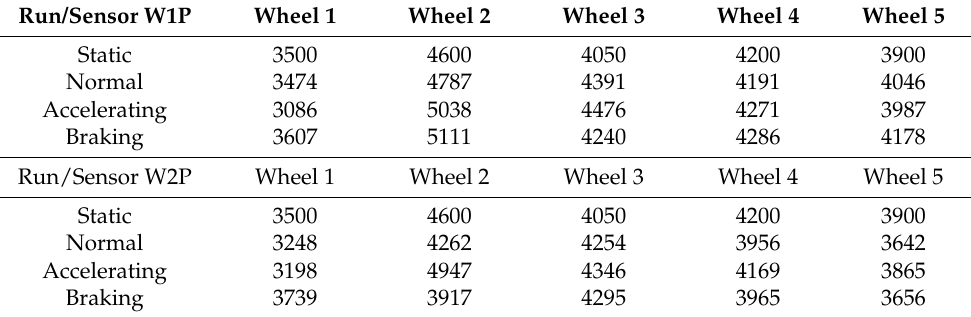
Table 9. Strain gauge sensor signal characteristics and reference static measurements—wheel load (kg).